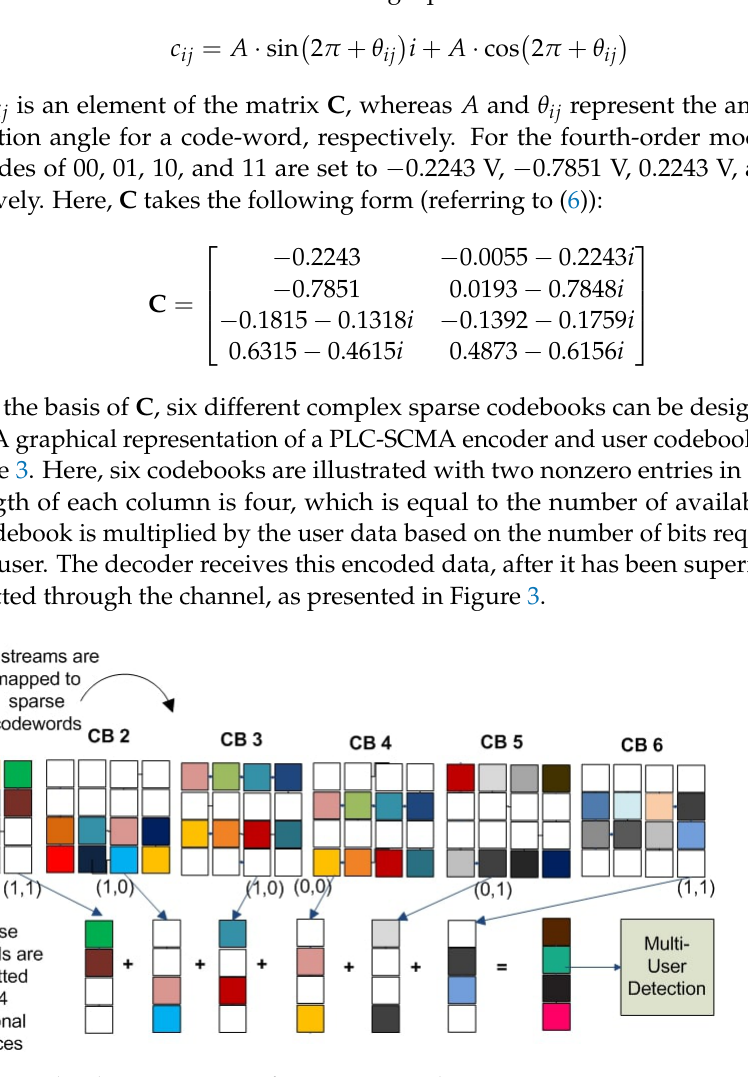
Figure 3. Graphical representation of an SCMA